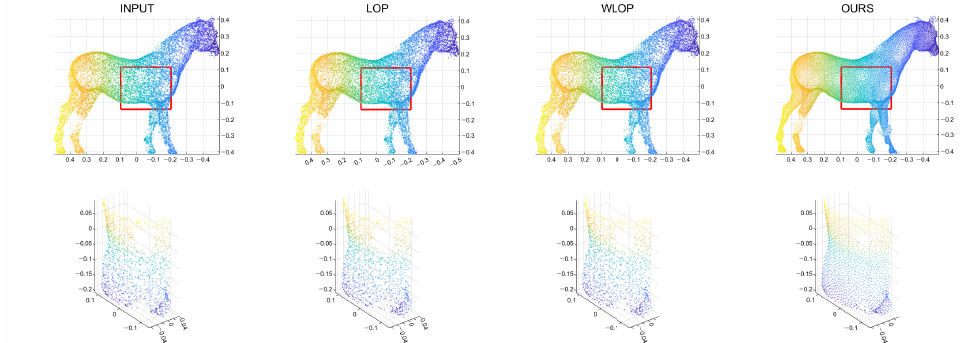
Figure 13. Qualitative results for an omnidirectional noise case with resampling ratio 0.5 (Horse). First column: input point cloud; second column: LOP; third column: WLOP; and fourth column: the proposed method. The second row shows enlarged views of the first row.